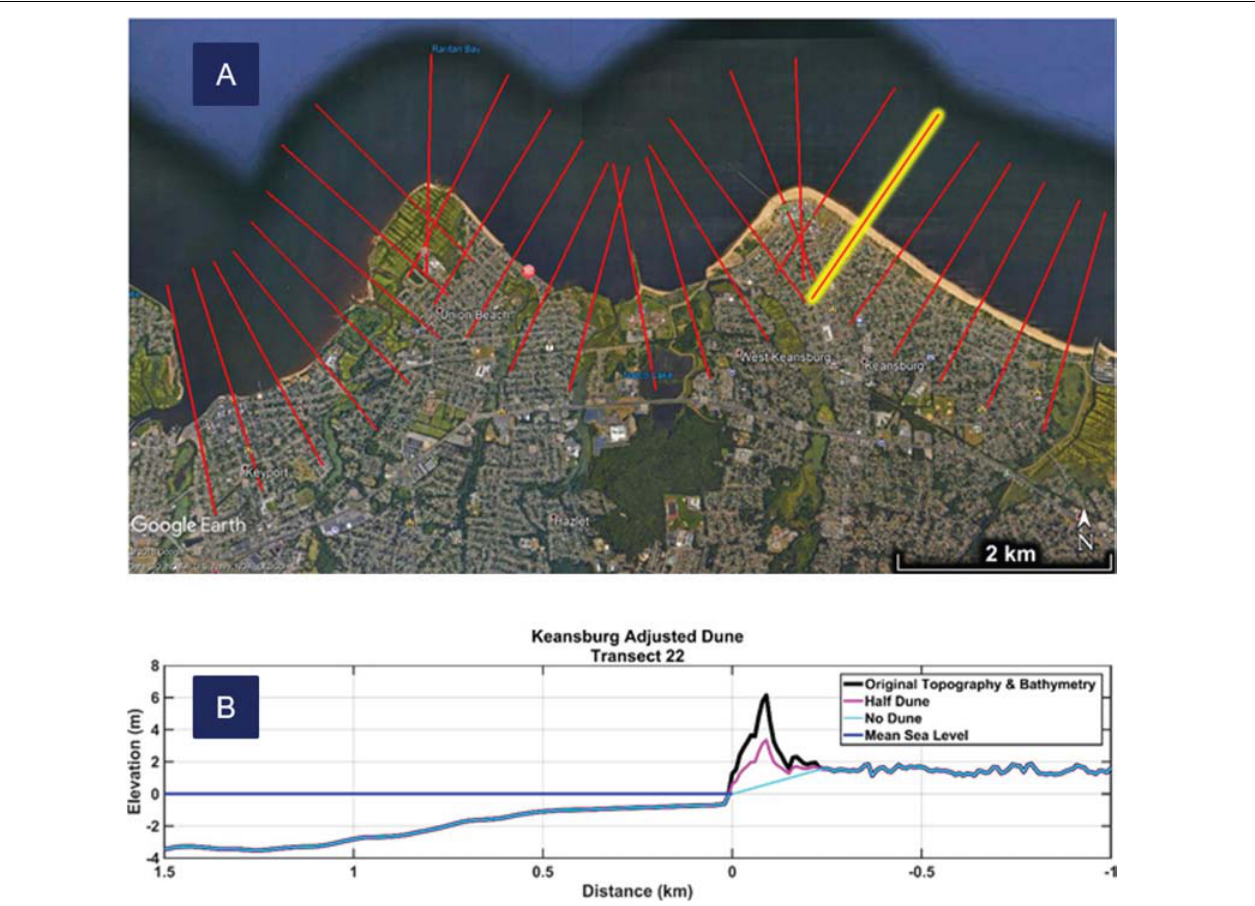
FIGURE 2 | (A) Google Earth view of Keansburg transects with transect #22 highlighted in yellow. (B) Cross sectional view of transect #22 showing the profile of the original topography & bathymetry (current), degraded, and compromised profiles as an example of how these coastal protection scenarios were simulated.